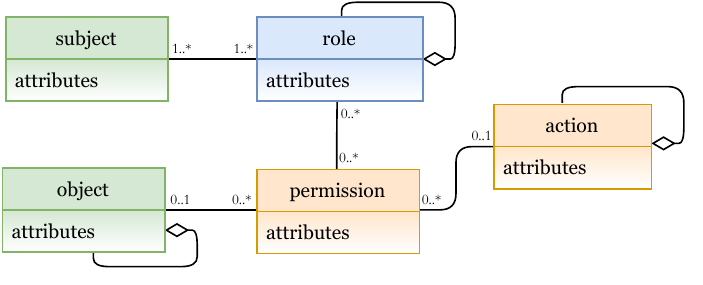
Figure 10. RBAC model instance.